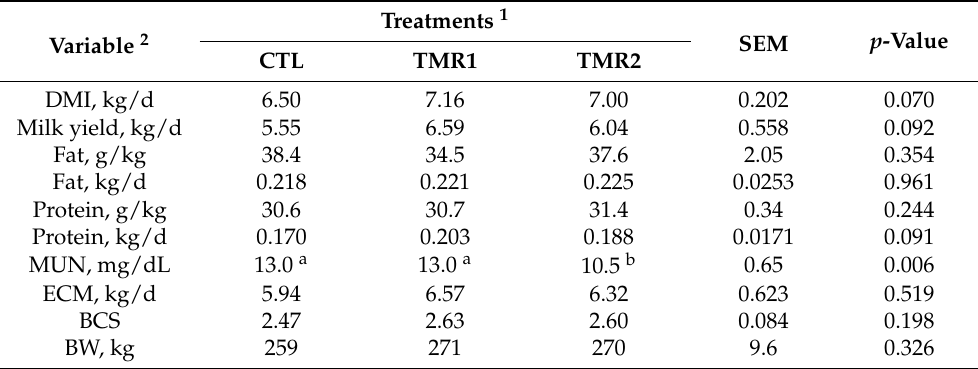
Table 4. Dry matter intake, milk production performance and body